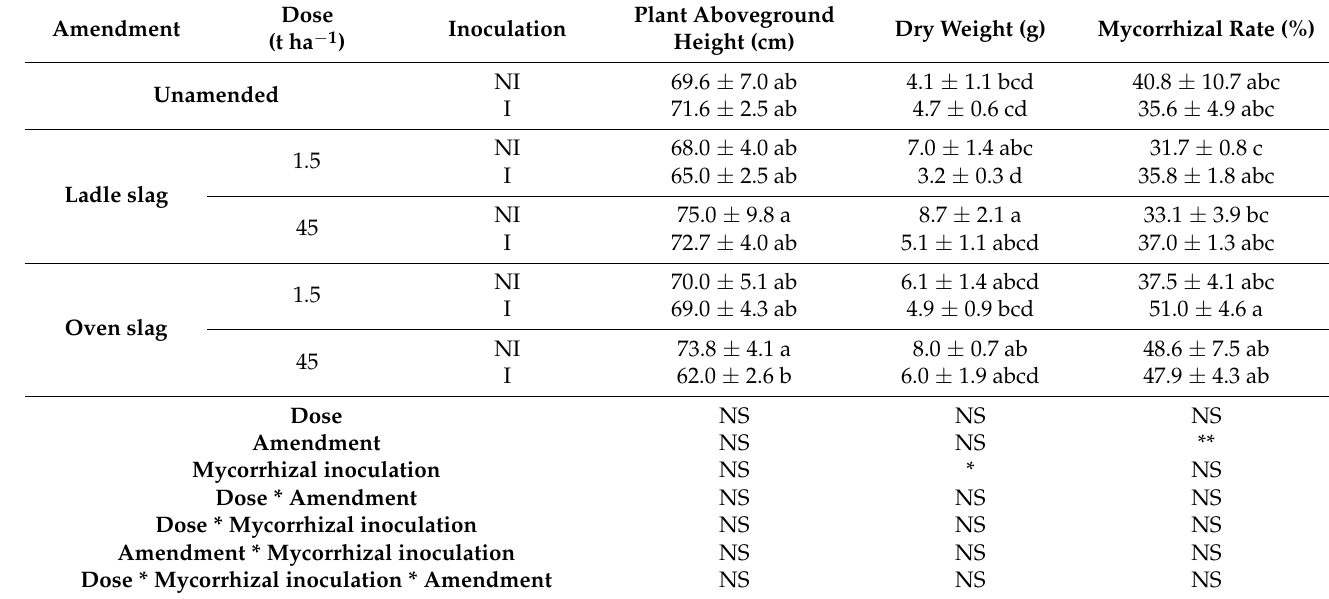
Table 1. Growth parameters and mycorrhizal rate of coriander. Data are presented as means ± stan- dard error. The means were obtained from five replicates ( n = 5) for height and dry weight of plants, and three replicates ( n = 3) for mycorrhization rate. Means followed by the same letter are not significantly different, by one-way ANOVA comparison and post-hoc Fisher test ( α =